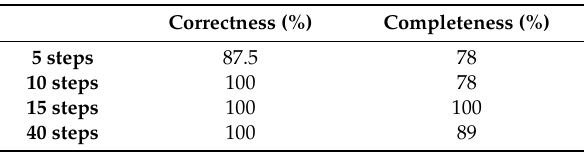
Table 1. Correctness and completeness of window detection approach utilizing different sizes of partitioning (steps).